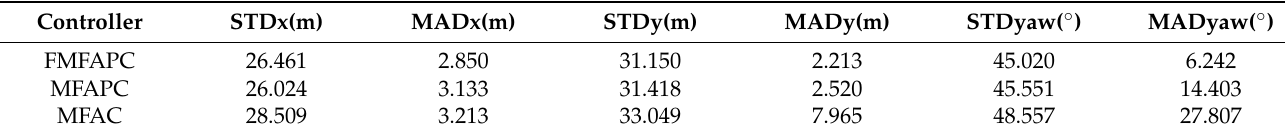
Figure 4. ( a ) PJM estimation results of controllers. ( b − d ) Tracking errors. Table 4. STD and MAD of controllers under Scenario